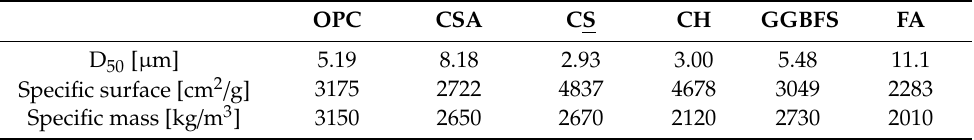
Table 2. Physical properties of